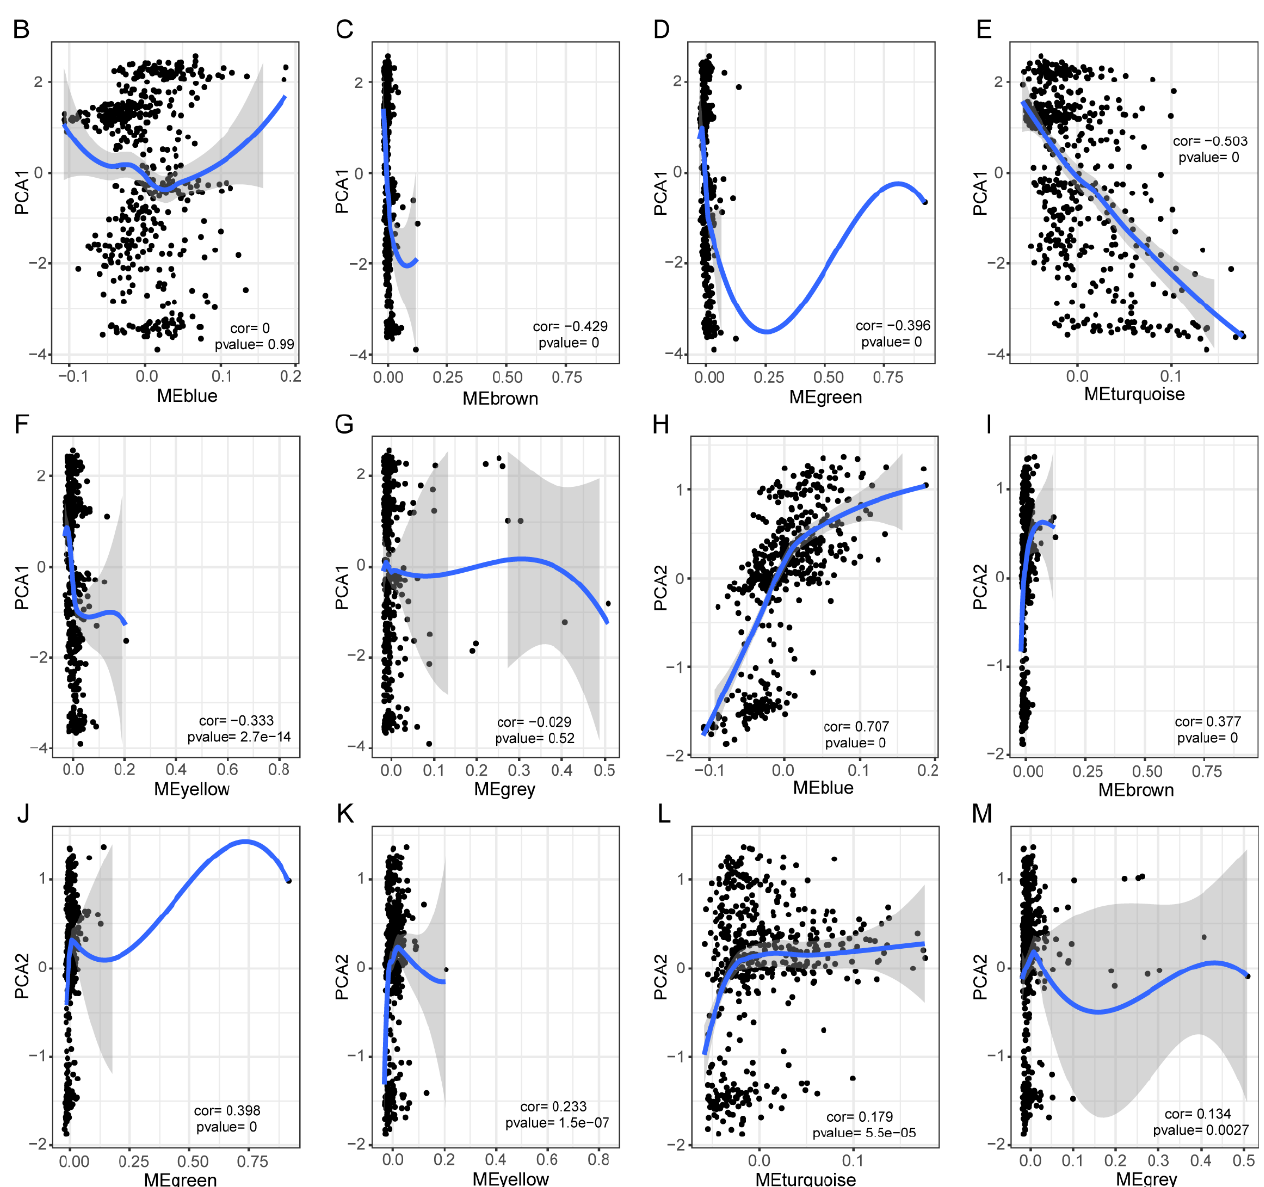
Figure 10. Identification of key immune genes of HNSC. ( A ) Forest maps of single-factor survival analysis of six modules of HNSC. ( B – G ) Correlation between six module feature vector and PCA1 in immune landscape. ( H – M ) Correlation between six module feature vector and PCA2 in immune landscape.